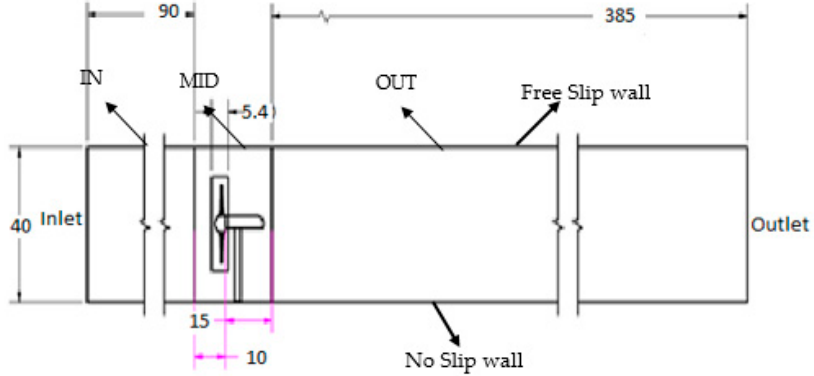
Figure 3. Demonstration of computational domain.